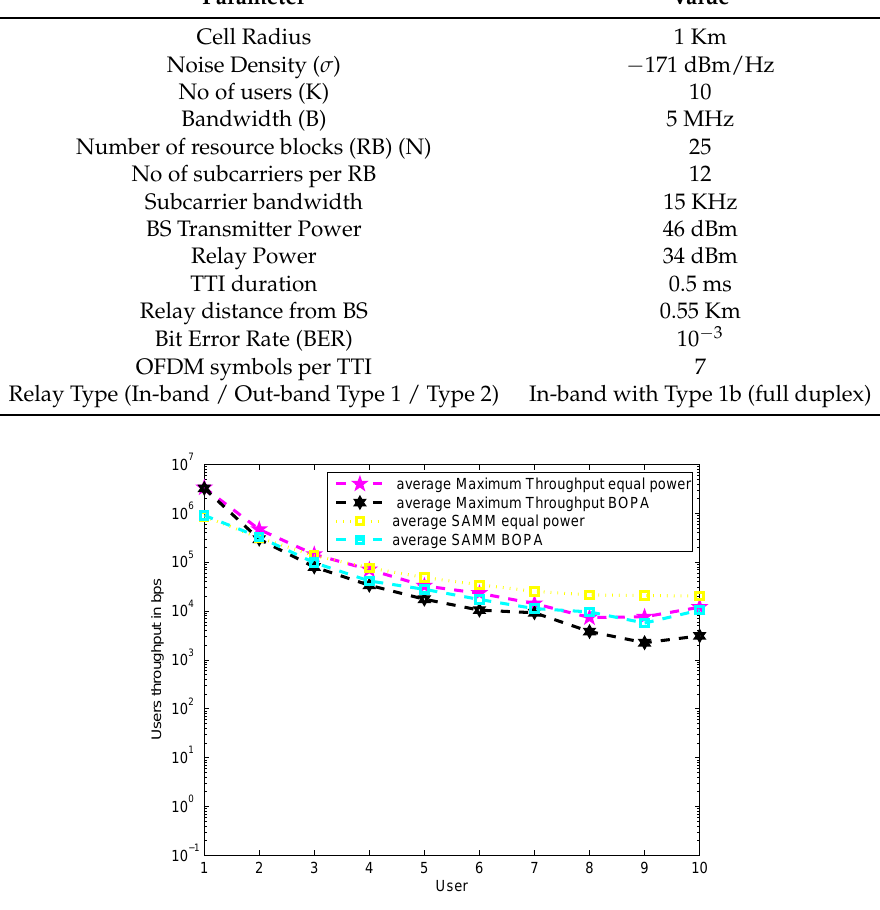
Figure 2. User vs. Throughput averaged over thousand times for SAMM and MT with equal power and BOPA.